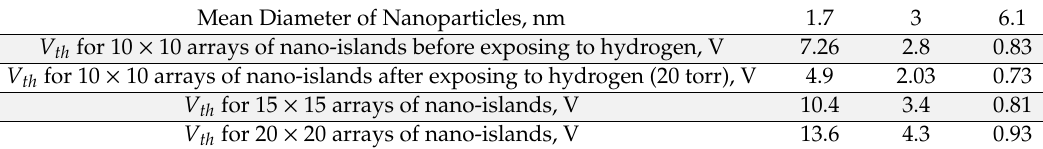
Figure 3. The I ds − V ds characteristics of arrays for ( a ) 1.7, ( b ) 3, and ( c ) 6.1 nm nano-islands, simulated by spreading the array size at room temperature. Table 2. V th calculated from the extrapolation of linear regions to